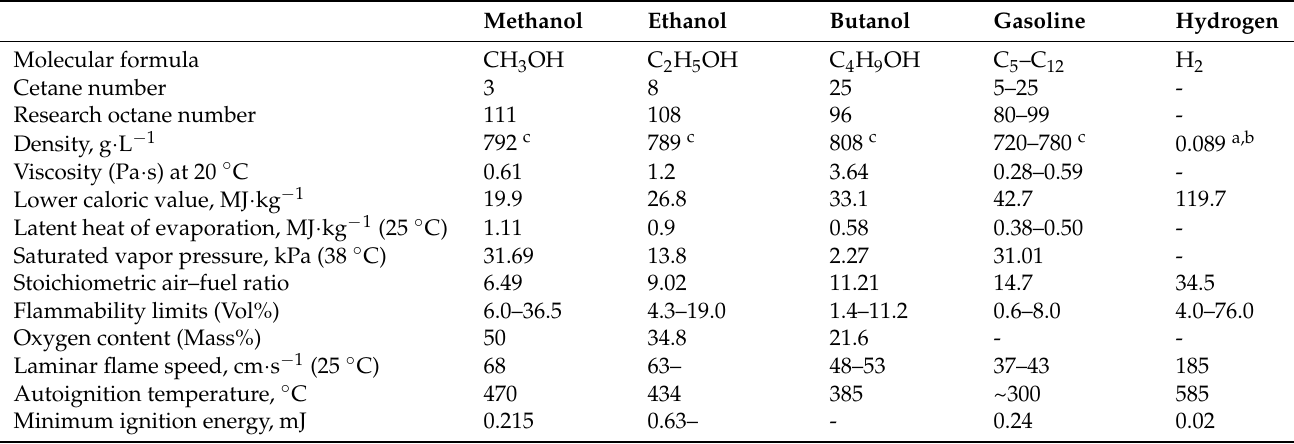
Table 1. The properties of alcohol